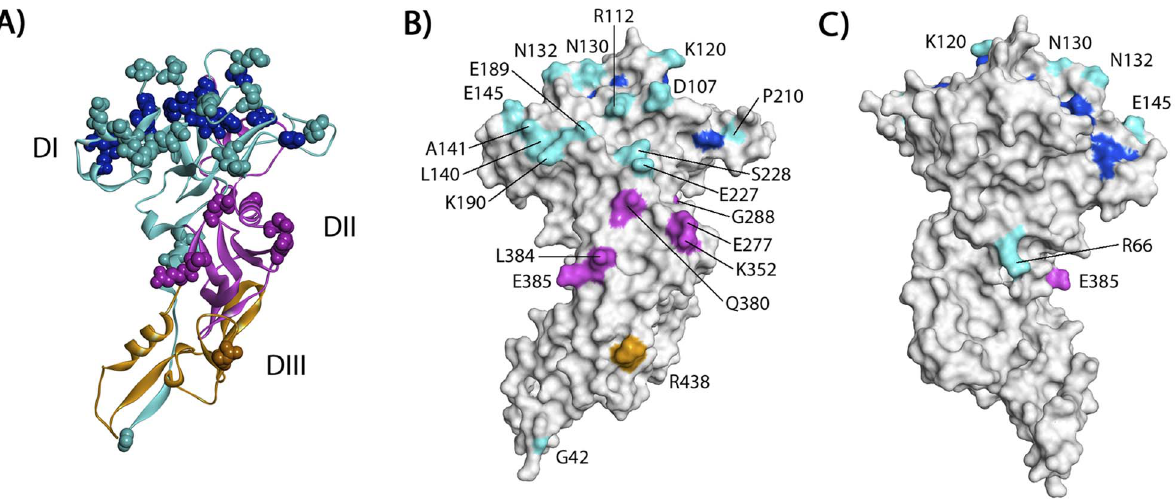
Figure 3. Location of 22 polymorphic Pv AMA1 residues predicted to be under balancing selection. A) Ribbon diagram of the PvAMA1 model showing each of the Pv AMA1 domains (DI in cyan, DII in magenta, and DIII in orange) and the hydrophobic ligand binding cleft (dark blue). Each of the 22 residues under selection and the 12 hydrophobic cleft residues are shown by CPK-models of their atoms (spheres) and are coloured according to location. B) Solvent-accessible surface representation of the ‘active face’ of the Pv AMA1 model. The hydrophobic cleft and polymorphic residues are shown, with colouring as described for panel A. C) Solvent-accessible surface representation of the ‘silent face’ of the Pv AMA1 model. The hydrophobic cleft and polymorphic residues are shown, with colouring as described for panel A.